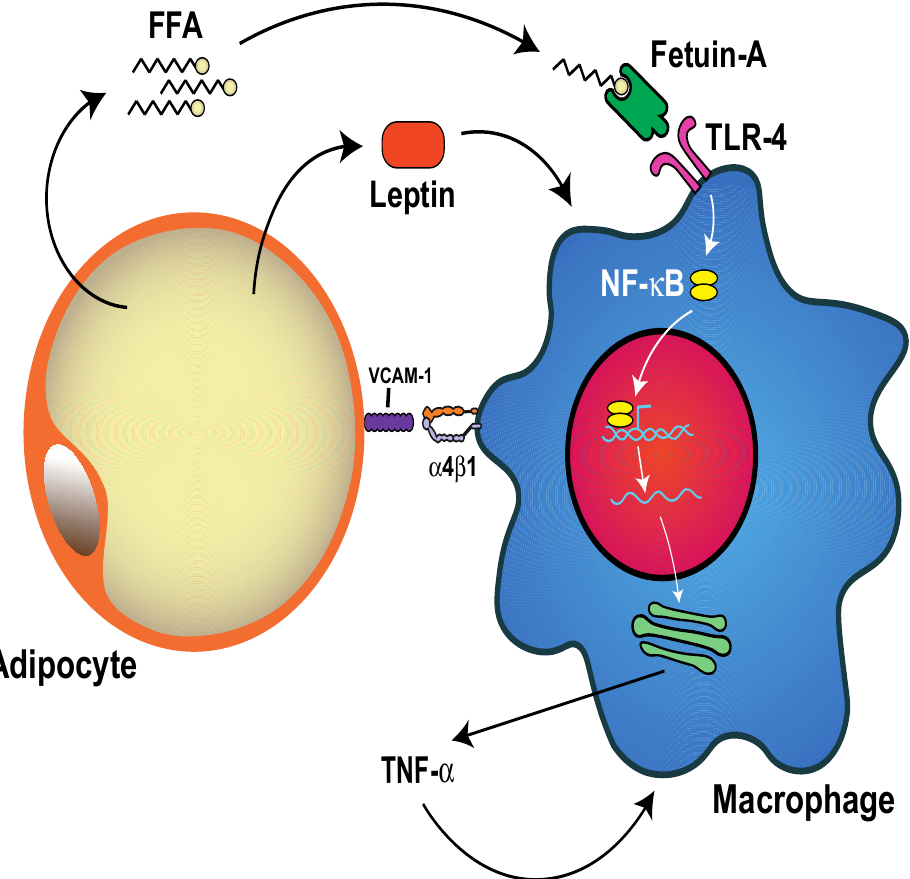
Figure 2. Interaction of adipocytes and macrophages in obese adipose tissue. Macrophages enter in direct contact with adipocytes through adhesion of integrin α 4 β 1 on macrophages with vascular cell adhesion molecule-1 (VCAM-1) on adipocytes. Free fatty acids (FFA) produced by lipolysis are released by adipocytes and bind to fetuin-A, which is then recognized by toll-like receptor 4 (TLR-4) on macrophages. This leads to the activation of proinflammatory signals like the nuclear factor kappa B (NF- κ B) pathway that induces secretion of cytokines such as tumor necrosis factor alpha (TNF- α ) by macrophages. The leptin released by adipocytes also induces macrophages to produce TNF- α . Further activation of macrophages by TNF- α creates a self-sustained inflammation in obese adipose tissue.